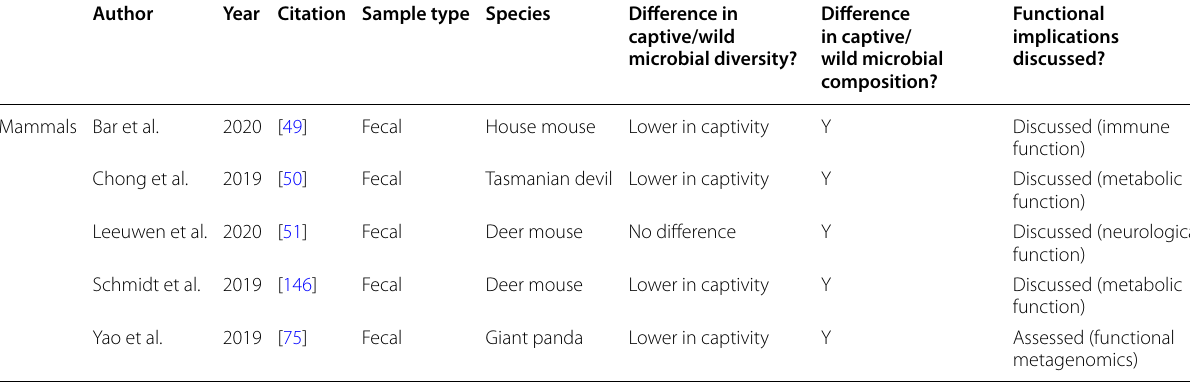
Included is whether the paper reported an increase or decrease in microbial diversity and microbial composition, as well as whether functional implications of these differences were discussed or assessed. Papers were found with a directed review of existing literature including a Google Scholar search and consulting references cited in each paper collected. We retained only those studies which include a captive population released into the wild within a single